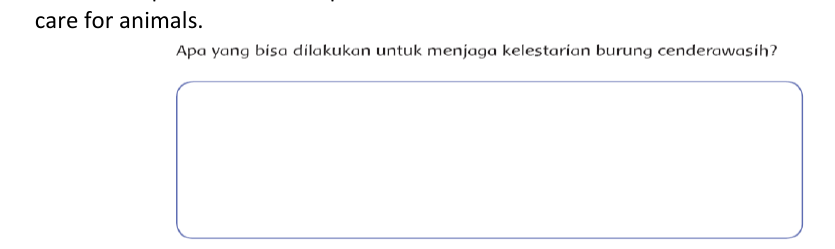
Figure 13: The question about preserving the sustainability of the bird of paradise